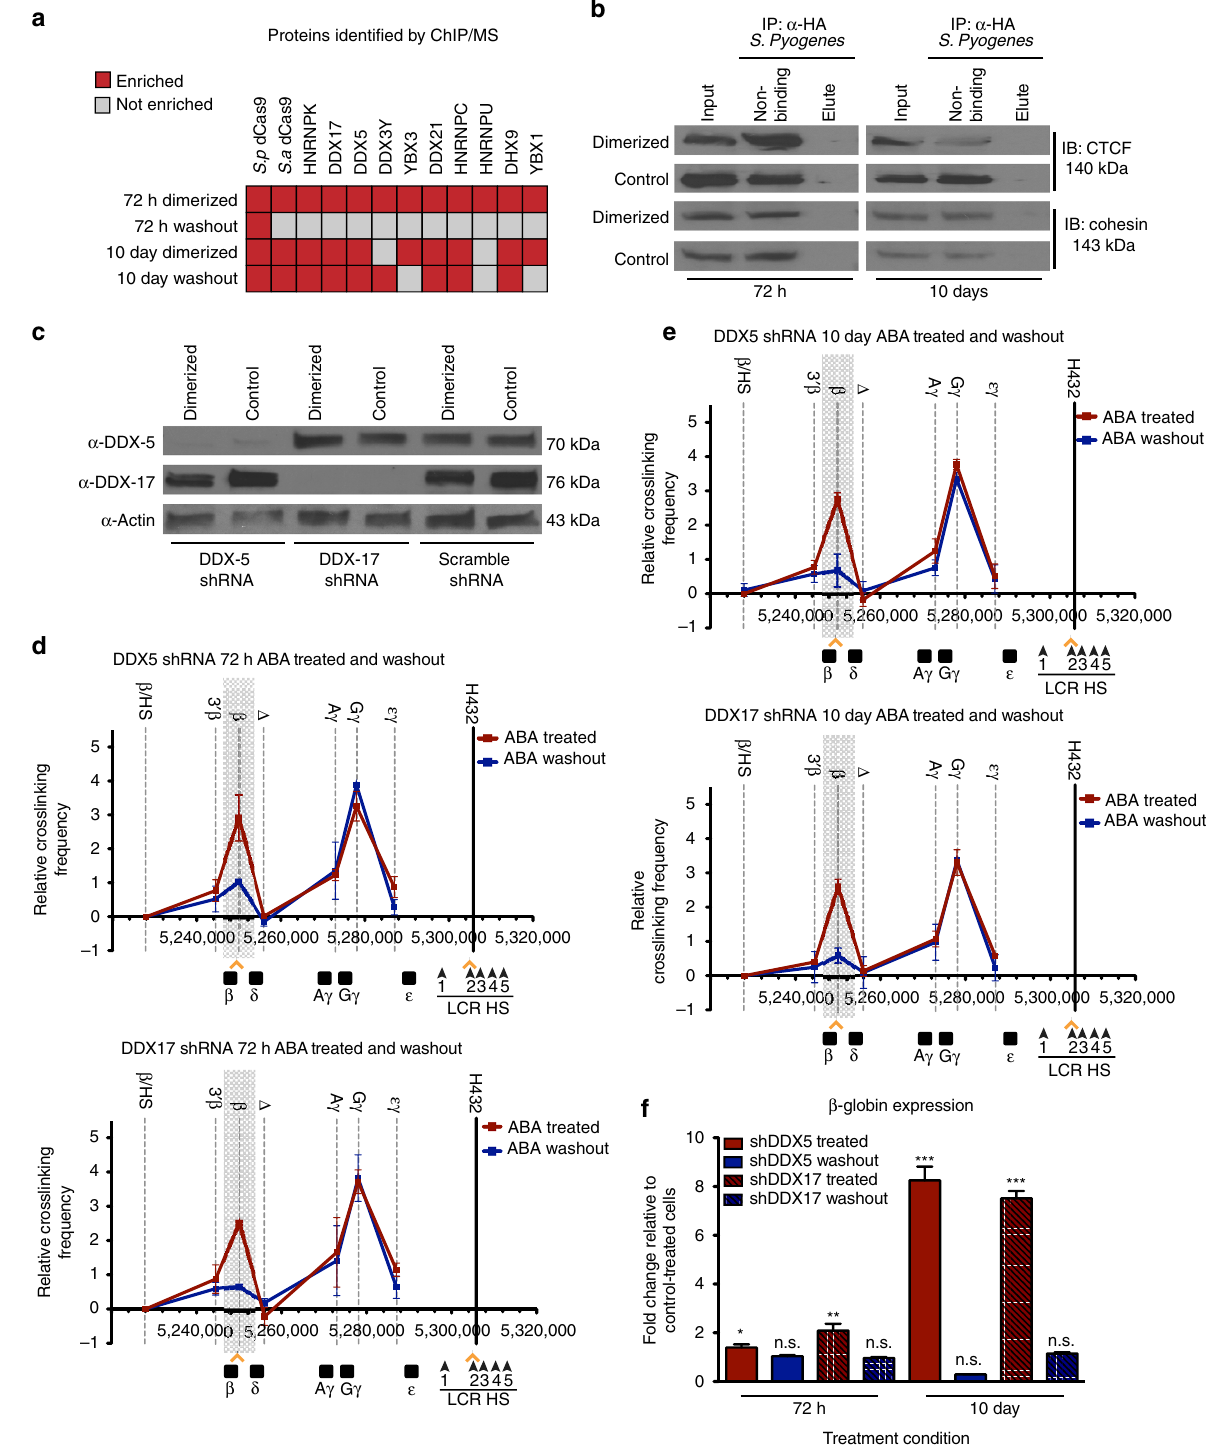
Figure 4 | RNA helicases DDX5 and DDX17 stabilize long-term chromatin loops. ( a ) MS/ChIP of dimerized CLOuD9 cells after 72h and 10day treatments demonstrate differential enrichment of novel proteins at the induced looping loci after 10 days. ( b ) Immunoprecipitation of CLOuD9 complexes demonstrates that CTCF and cohesin were not found to be localized to the induced loops. ( c ) shRNA knockdown of DDX5 and DDX17 in K562s containing CLOuD9 constructs. ( d , e ) 3C demonstrates that while DDX5 and DDX17 knockdown do not affect induction of b -globin-LCR contacts, the induced chromatin loops are no longer stabilized following 10 days of dimerization and subsequent washout. 3C values were normalized to tubulin, and interaction frequencies between the anchor fragment and the fragment encompassing the b /HS fragment were set to zero. Error bars indicate s.d. n ¼ 3. ( f ) Endogenous b -globin expression is restored following short- and long-term dimerization and subsequent ligand washout in DDX5 and DDX17 knockdown cells. Significance given relative to control treated cells. Two-tailed student’s t -tests * P o 0.05, t ¼ 2.538, df ¼ 6; ** P o 0.001, t ¼